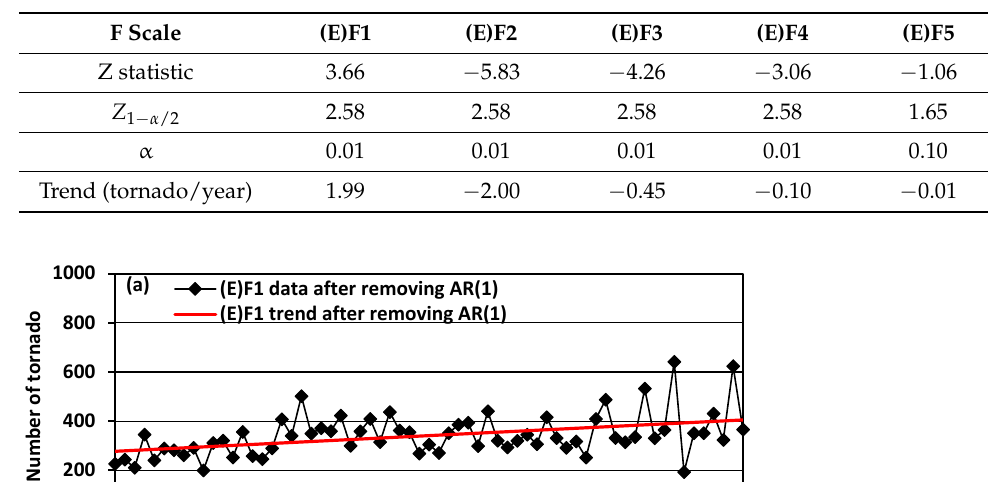
Table 4. Mann-Kendall test for U.S. tornado (E)F1 to (E)F5 frequency trends.